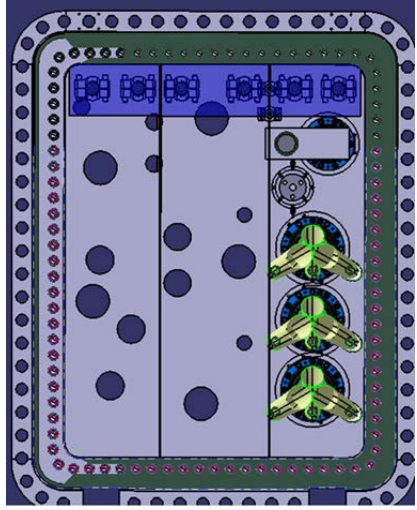
Fig. 2. CAD drawing of the closure plate of equatorial port plug #12 seen from outside the vacuum vessel. DSM #3 is to the right. The launcher line window (Ø110mm CVD) is in the top and below are the three receiver windows (Ø160mm fused silica double disk).